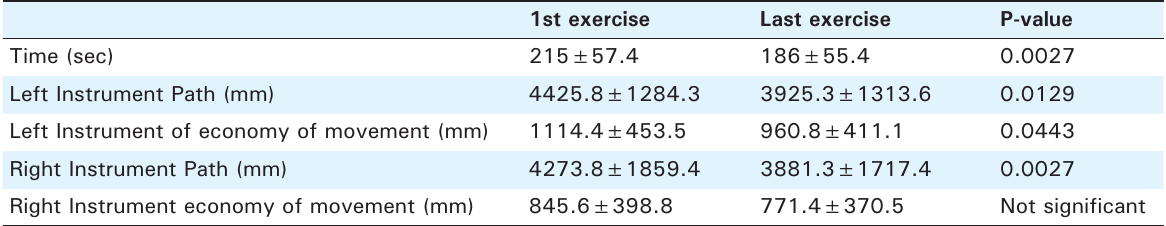
Table 1. Results of tasks in the fi rst and last